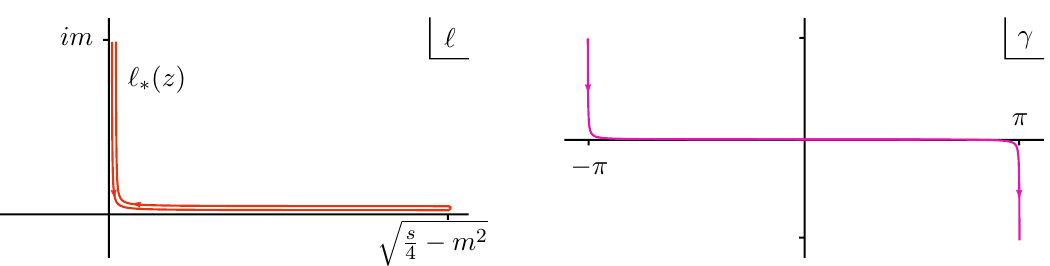
√ √ √ = ( s − s − 4 m 2 ) / (2 s ) and ∗